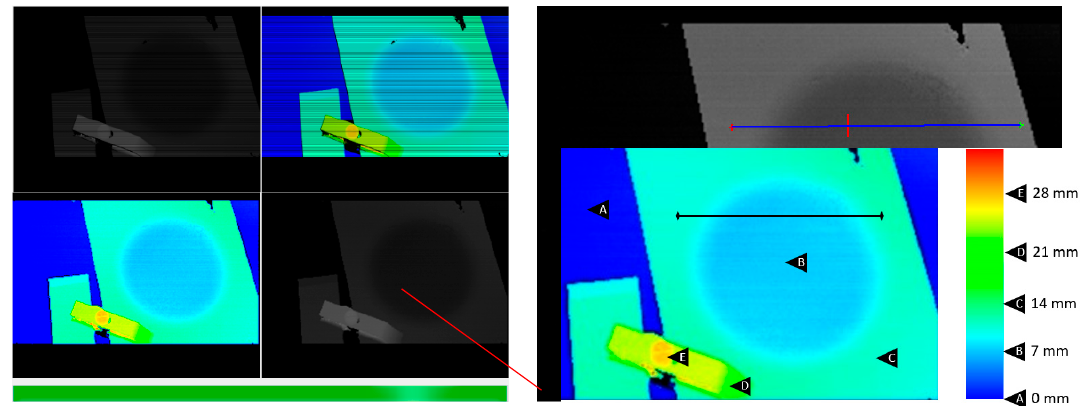
Figure 18. 3D map of a scanned block and a programmed robot trajectory for welding.